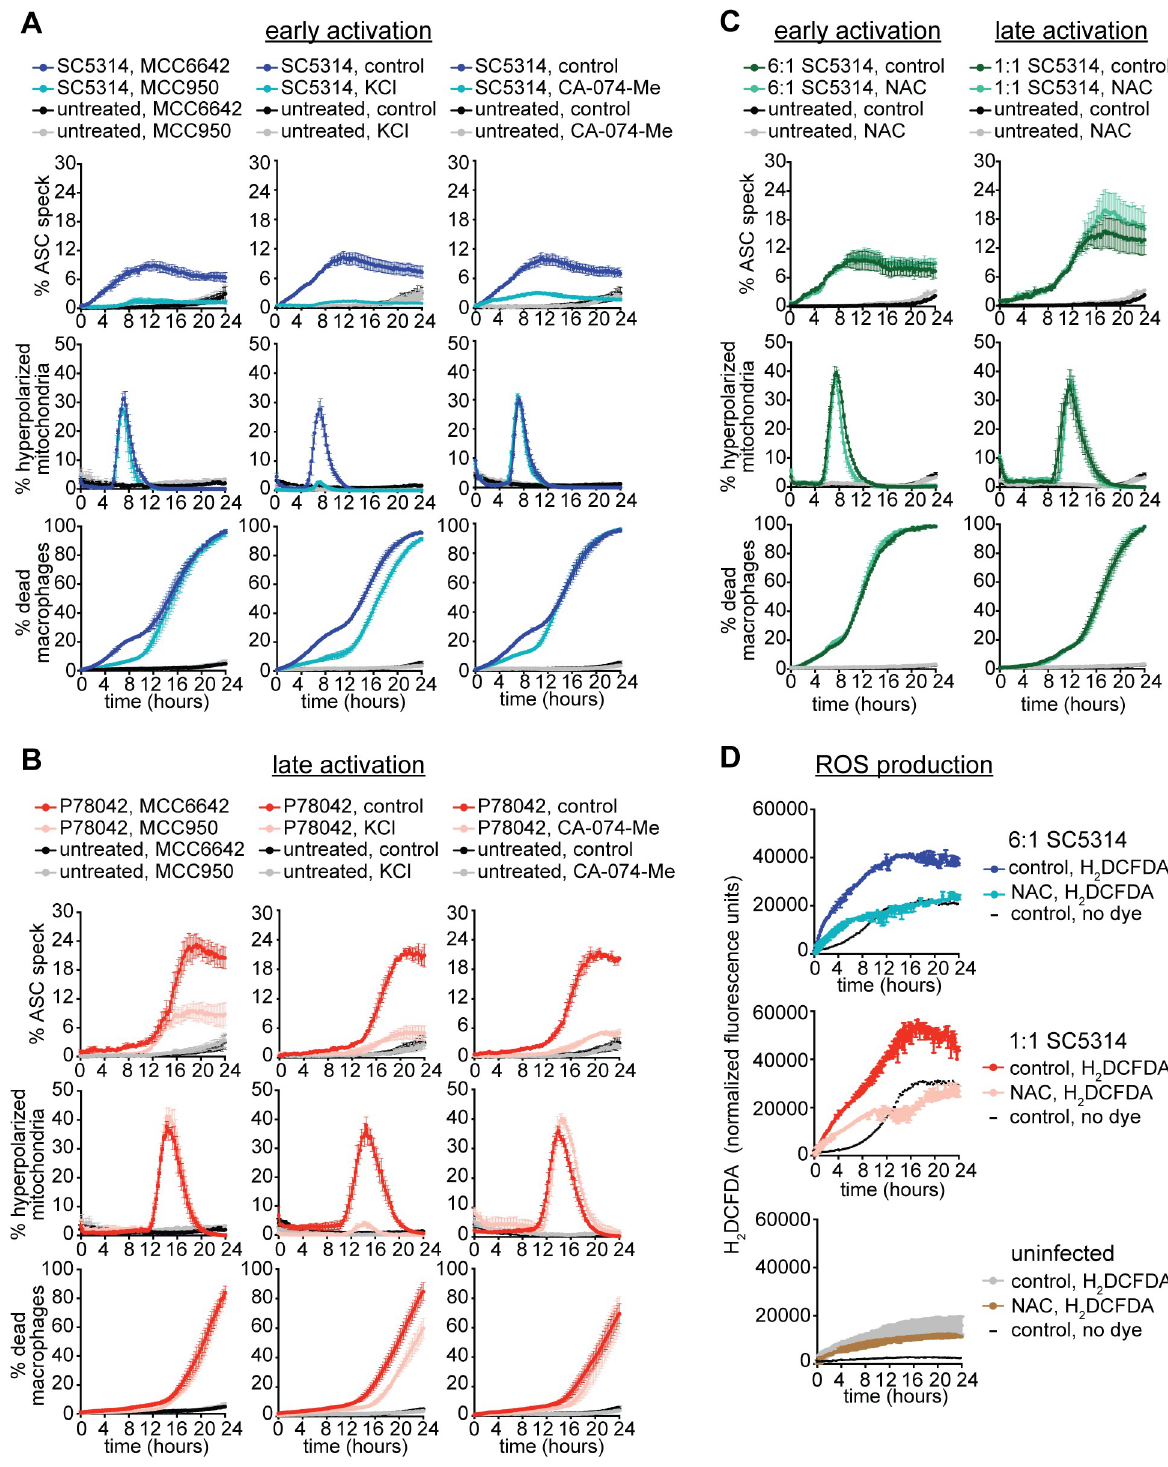
Fig 4. The second mechanism of inflammasome activation depends on NLRP3, potassium efflux and release of the lysosomal protease cathepsin B. (A) To assay the early event of inflammasome activation, ASC-mCerulean-expressing immortalized macrophages were challenged with Candida strain SC5314 (MOI 6:1). Uninfected macrophage controls were also included. The % macrophages containing an ASC speck, % macrophages with hyperpolarized mitochondria and % dead macrophages were quantified in live cell imaging experiments. Comparisons were assessed in the presence of the NLRP3 inhibitor MCC950 (10 μ M) or the control inactive compound MCC6642 (10 μ M), in the presence of